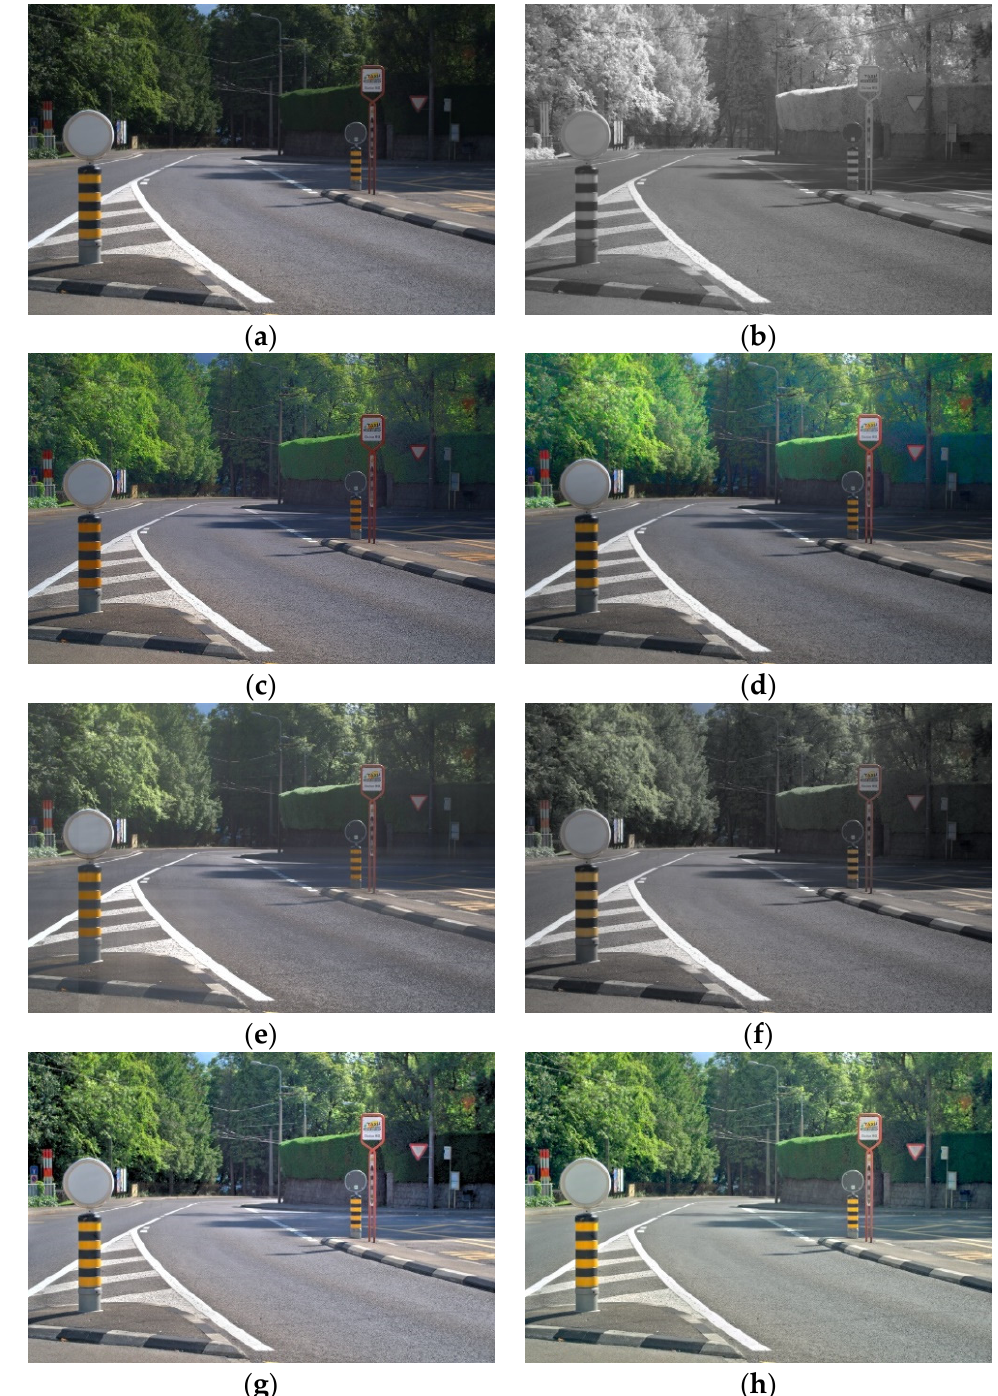
Figure 12. Input pair images and result images: ( a ) Visible image, ( b ) IR image, ( c ) Laplacian pyramid entropy fusion, ( d ) Laplacian pyramid PCA fusion, ( e ) Low rank fusion, ( f ) dense fusion, ( g ) Proposed method (Luminance channel fusion), ( h ) Proposed method (XYZ channel fusion).